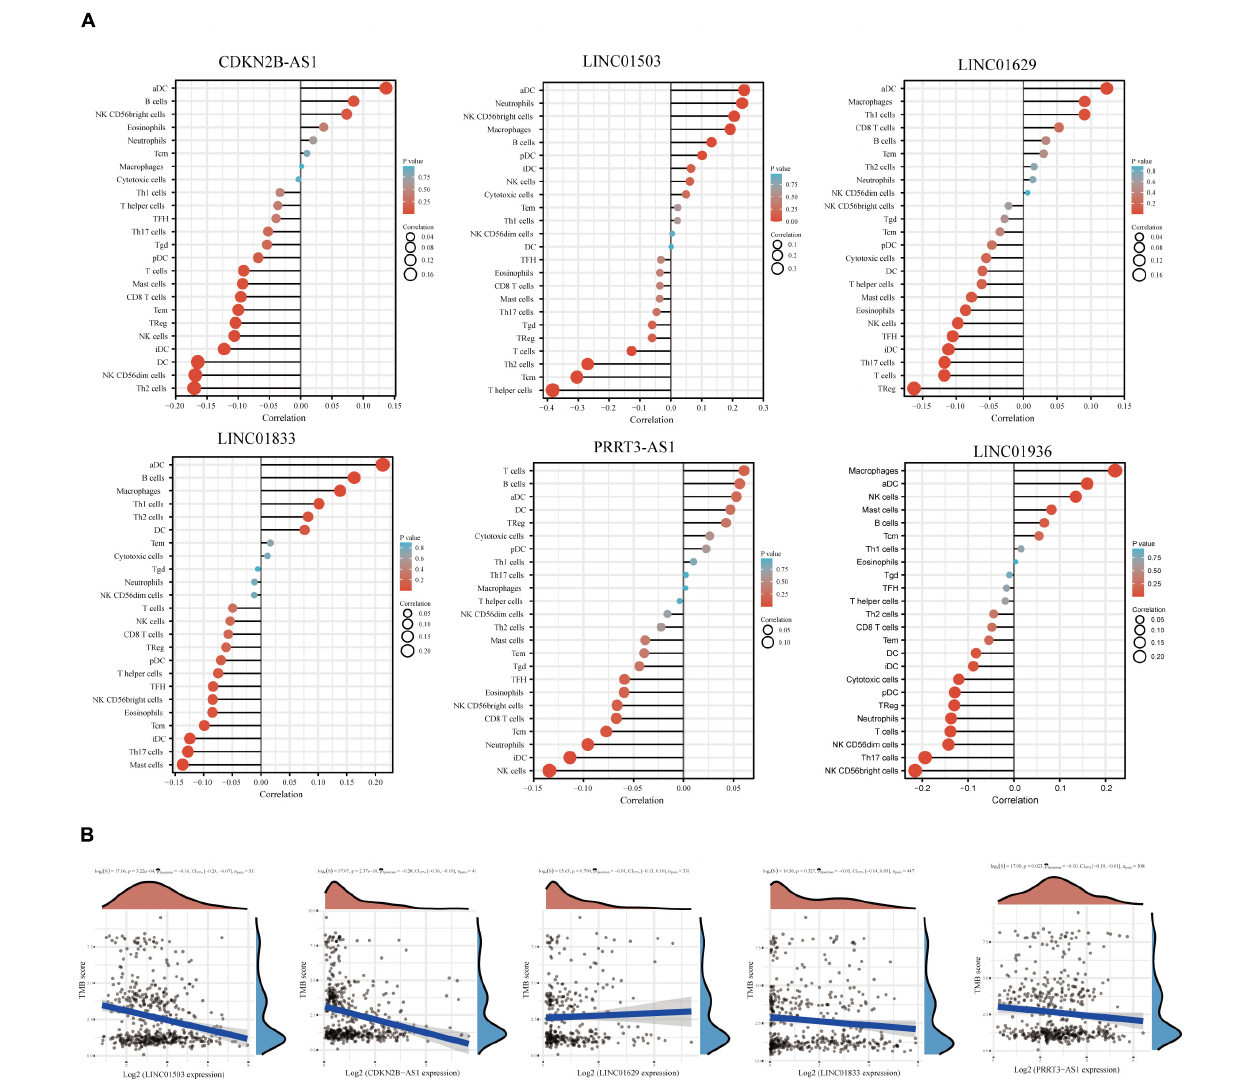
FIGURE 5 | Correlation between lncRNA expression and immune infiltration. (A) Correlation analysis of immune-related lncRNA expression and the infiltration of aDCs, B cells, CD8+ T cells, cytotoxic cells, DCs, eosinophils, iDCs, macrophages, mast cells, neutrophils, NK CD56bright cells, NK CD56dim cells, NK cells, pDCs, T cells, T helper cells, Tcm, Tem, Tfh, Tgd, Th1 cells, Th17 cells, Th2 cells, and Tregs. (B) Spearman correlation analysis of TMB/MSI and immune-related lncRNA expression. Horizontal axis represents gene expression distribution. Ordinate represents TMB/MSI score distribution. The density curve on the right represents the TMB/MSI score distribution trend. The upper density curve represents the gene expression distribution trend. The uppermost value represents the correlation p -value, correlation coefficient, and correlation calculation method. p -Values of < 0.05 were considered significant. The correlation coefficient range was (–1, 1), with a negative number representing a negative correlation between the expression of two genes and a positive value representing a positive correlation. The closer to 1 or –1, the stronger the correlation. The closer to 0, the weaker the